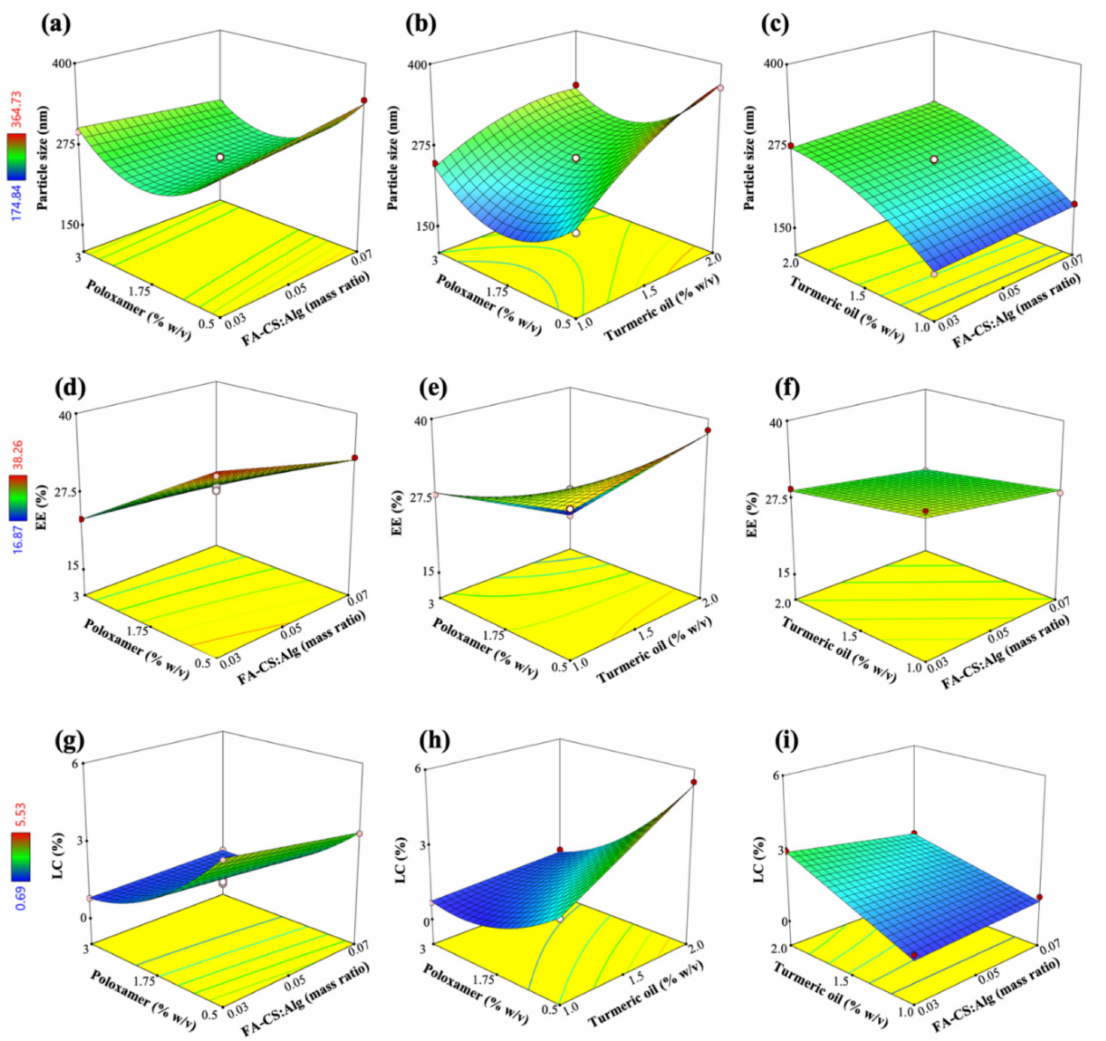
Figure 3. Response surface plots showing the effects of FA-CS:Alg mass ratio ( X 1 ), turmeric oil concentration ( X 2 ), and poloxamer concentration ( X 3 ) on ( a – c ) particle size ( Y 1 ), ( d – f ) EE ( Y 2 ), and ( g – i ) LC ( Y 3